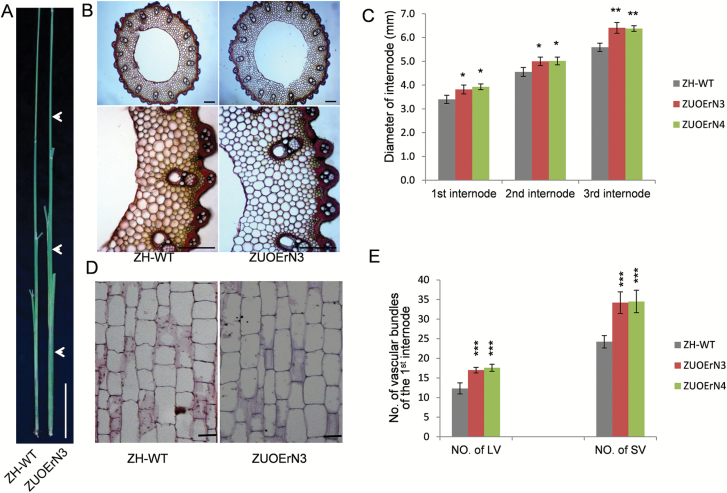
Internode phenotypes of ZUOErN plants. (A) Stem morphologies. The arrowheads indicated the elongated stem internodes. Scale bar=10 cm. (B) Cross-sections of the first elongated stem internodes. The photos below are enlarged images taken from the images above. Scale bars=200 μm. (C) Internode diameters. (D) Longitudinal sections of stem internodes. Scale bars=20 μm. (E) Numbers of large vascular bundles (LVs) and small vascular bundles (SVs) of the main stem at the first internode. ZH-WT, wild type Zhonghua 11. ZUOErN3 and ZUOErN4 are transgenic Zhonghua 11 plants overexpressing the miR164b-resistant OsNAC2 driven by the maize Ubiquitin1 promoter. Means ±SD are given in (C) and (E) (n=10). *P<0.05; **P<0.01 (t-test).